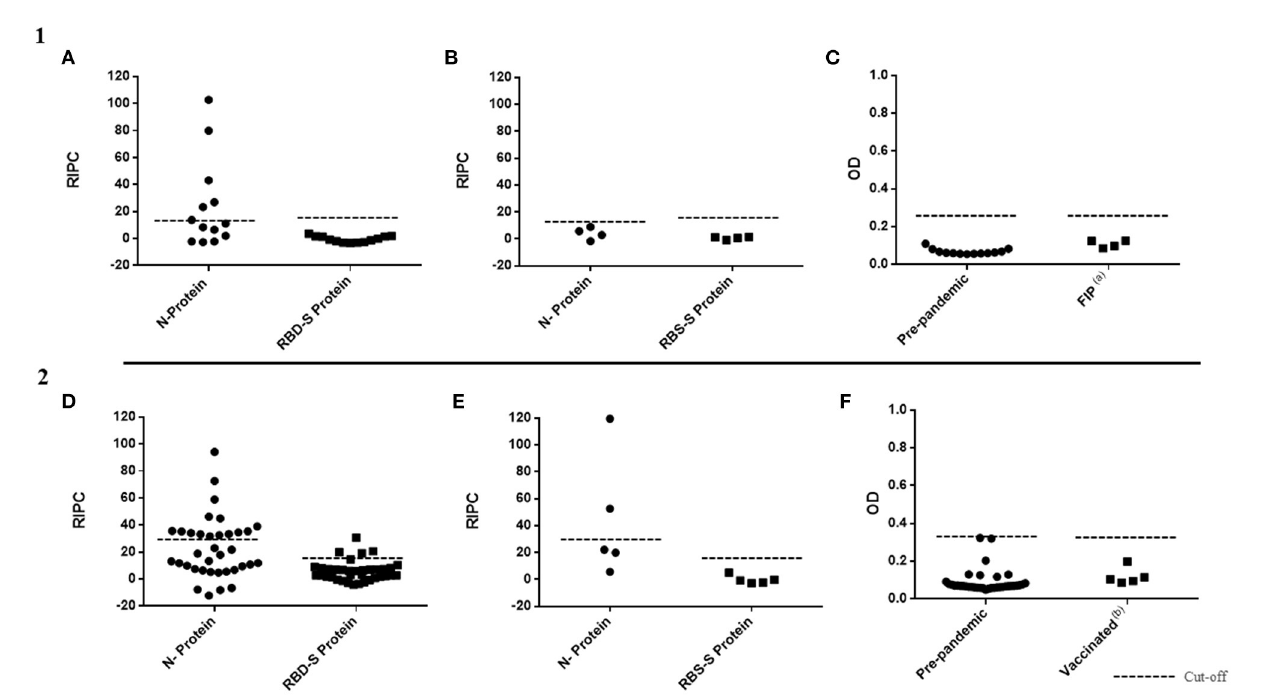
FIGURE2 Analytical specificity of N SALUVET ELISA, RBD-S SALUVET ELISA and INgezim ® COVID 19S VET developed for cats (1) and dogs (2). (A) Prepandemic cat sera analyzed by N and RBD-S SALUVET ELISAs; (B) sera from cats with feline infectious peritonitis (FIP) analyzed by N and RBD-S SALUVET ELISAs; (C) prepandemic and FIP sera analyzed by INgezim ® COVID 19S VET; (D) prepandemic dog sera analyzed by N and RBD-S SALUVET ELISAs; (E) sera from dogs vaccinated with canine coronavirus analyzed by N and RBD-S SALUVET ELISAs; (F) prepandemic and sera from dogs vaccinated with canine coronavirus analyzed by INgezim ® COVID 19S VET. RIPC, relative index percent; OD, optical density. (a) Cat sera from animals that died from feline infectious peritonitis (FIP). (b) Sera from dogs vaccinated with VANGUARD ® PLUS CPV/CV (Zoetis, New Jersey,